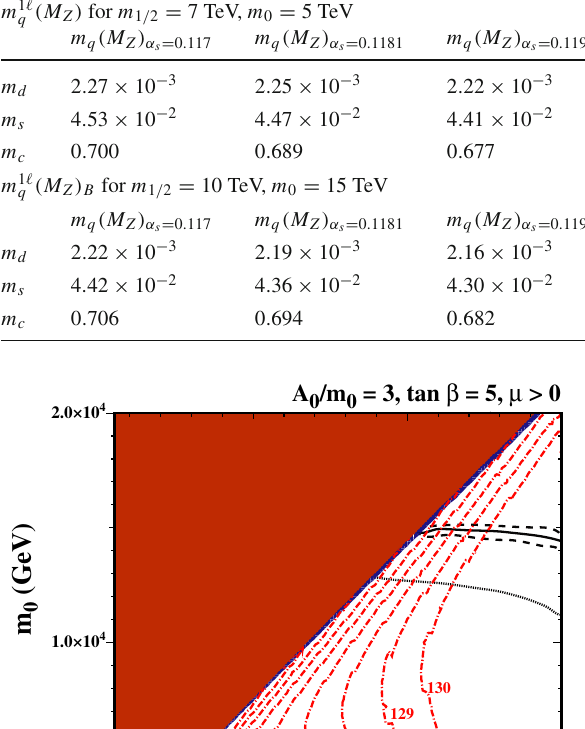
fore explore the sensitivity to this uncertainty through the fit- ted values of the Wolfenstein parameterisation of the CKM matrix